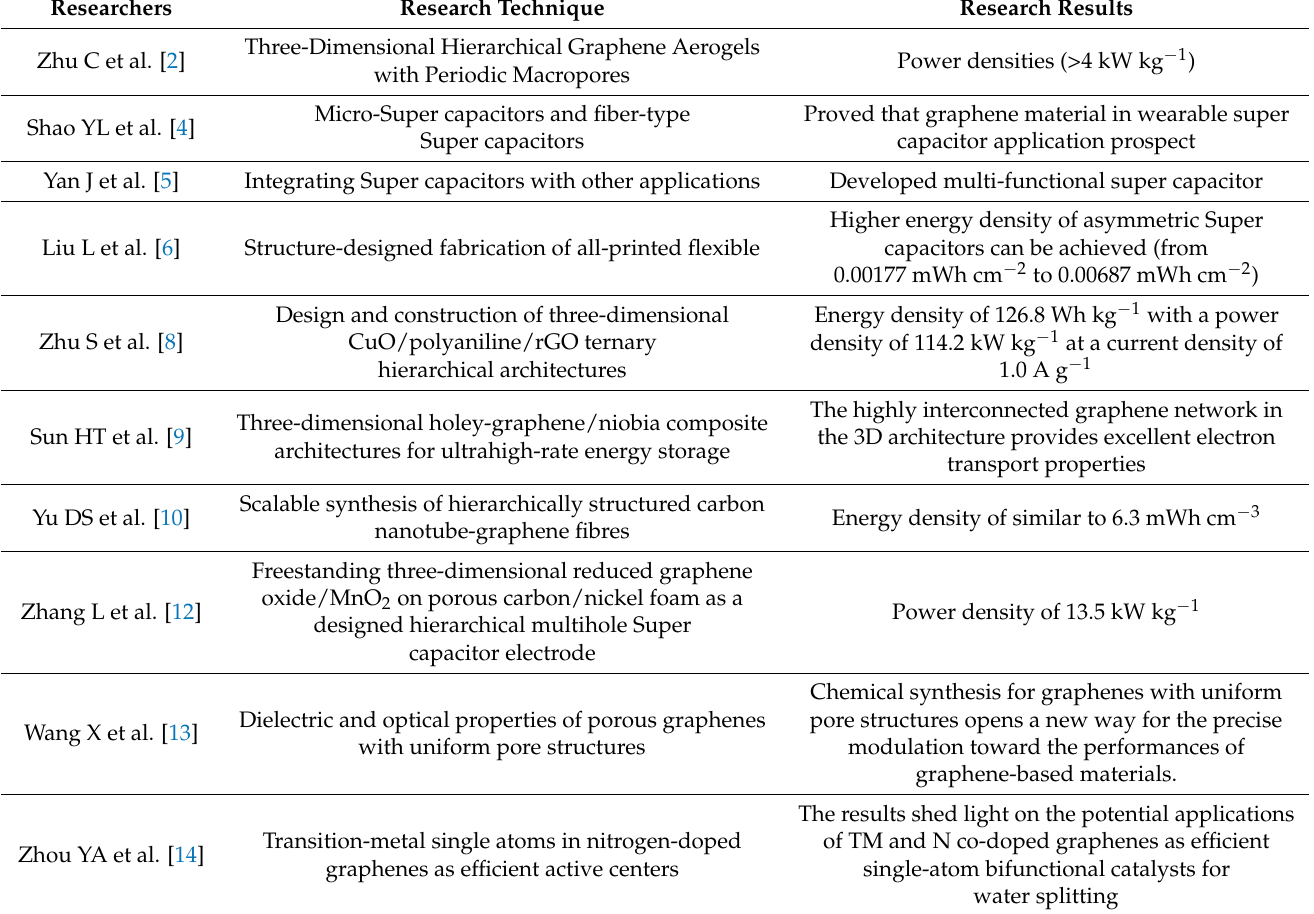
Table 1. Main research results on the properties of graphene supercapacitors and porous activated